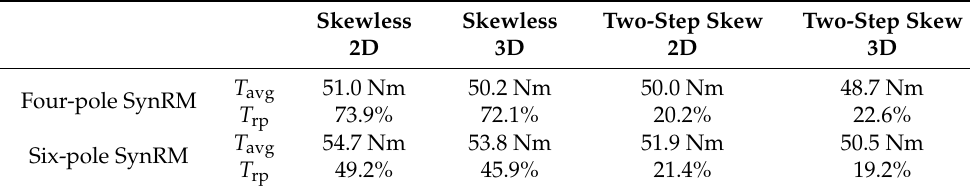
Table 4. Average torque and torque ripple comparison when applying two-step skewing, by means of 2D and 3D FEA